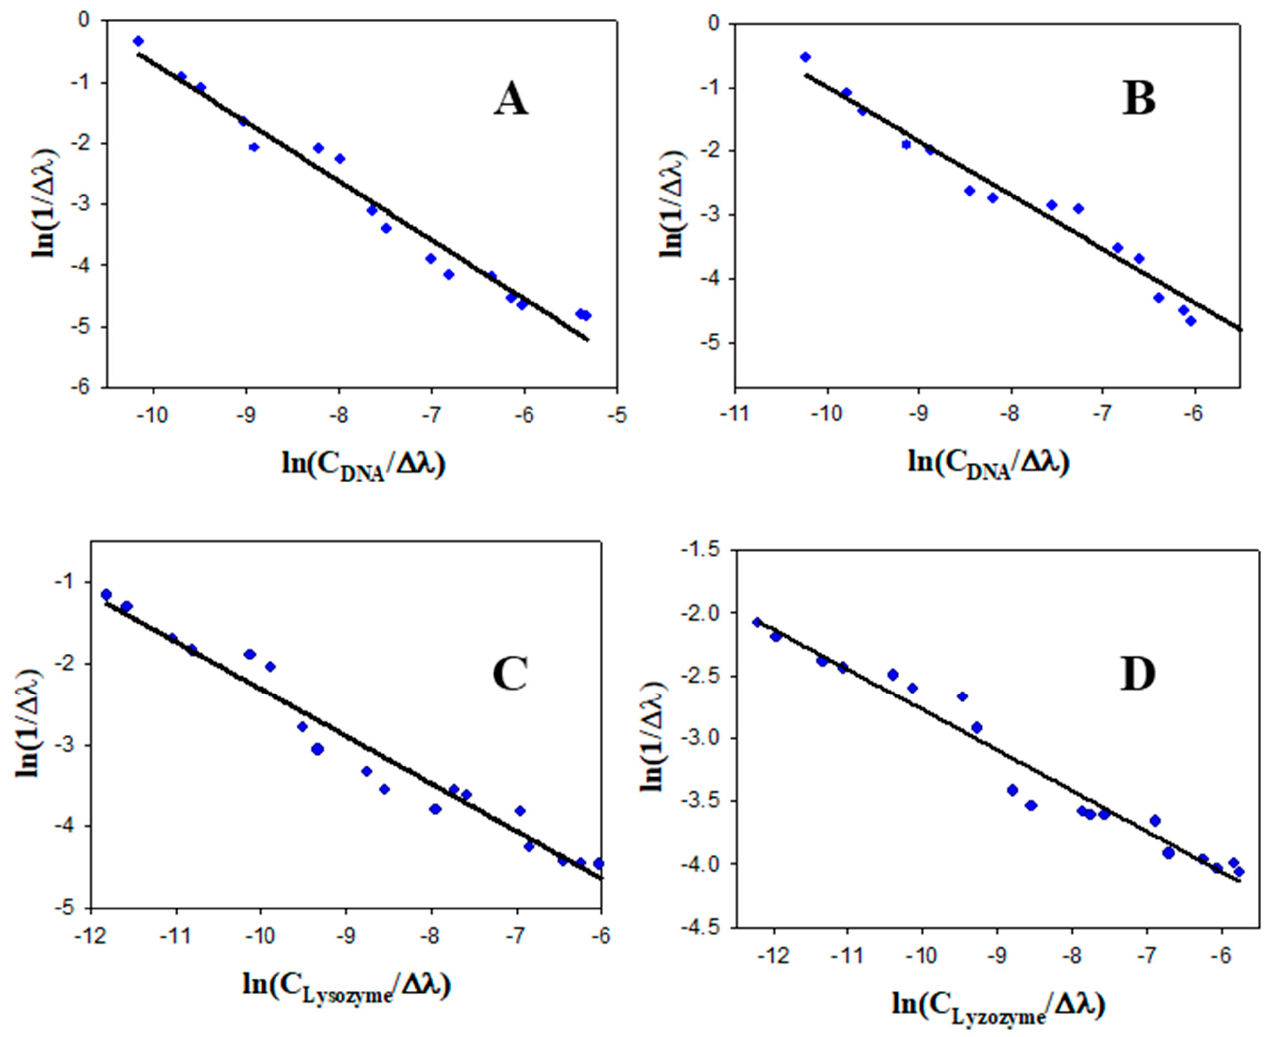
Figure 10. Colorimetric response patterns obtained with colorimetric sensors in horse serum media, showing the linear relationship between 1/ ∆ λ 2 logarithms and the logarithms of the quotient between biopolymer concentration and ∆ λ 2 . ( A ) Au@16-3-16/SDS/DNA system. ( B ) Au@16-6-16/SDS/DNA system. ( C ) Au@16-3-16/SDS/Lysozyme system. ( D ) Au@16-6-16/SDS/Lysozyme system.